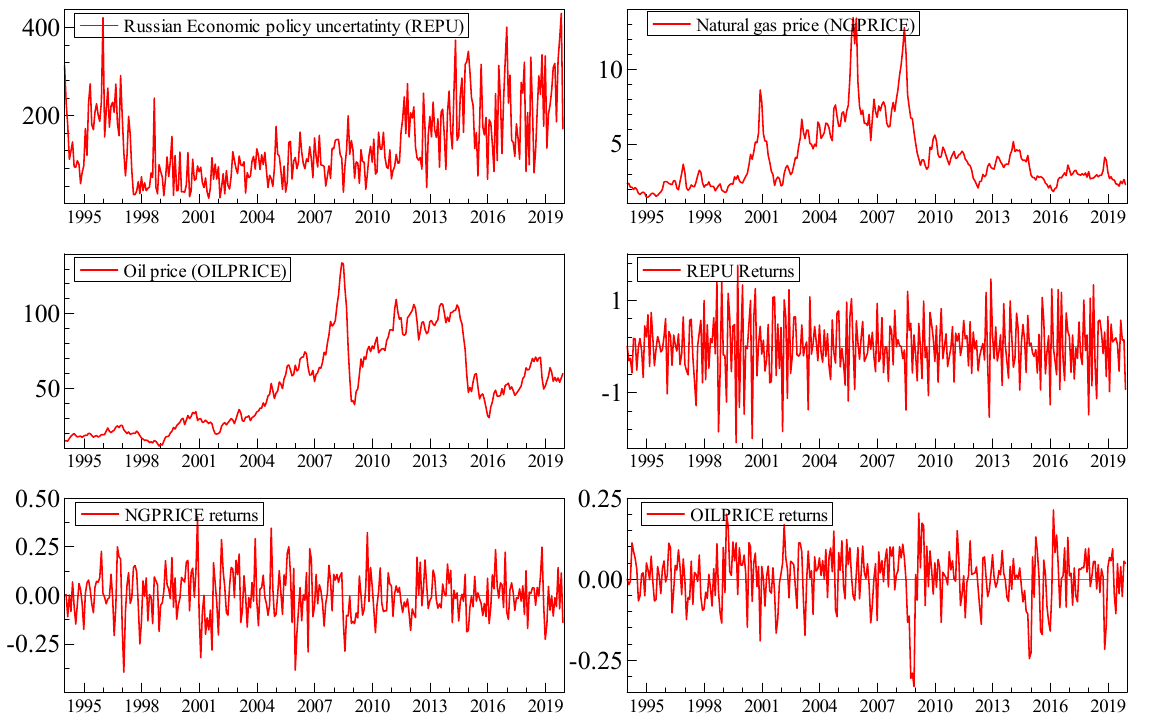
Figure 1. Dynamics of the monthly Russian economic policy uncertainty and energy prices and their returns .